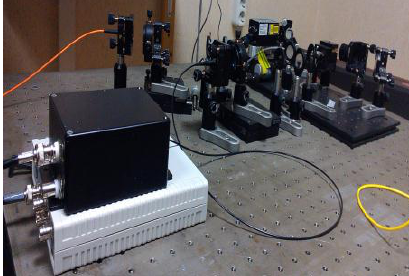
Fig. 1. General view of the single photon counters and time-digital convertors